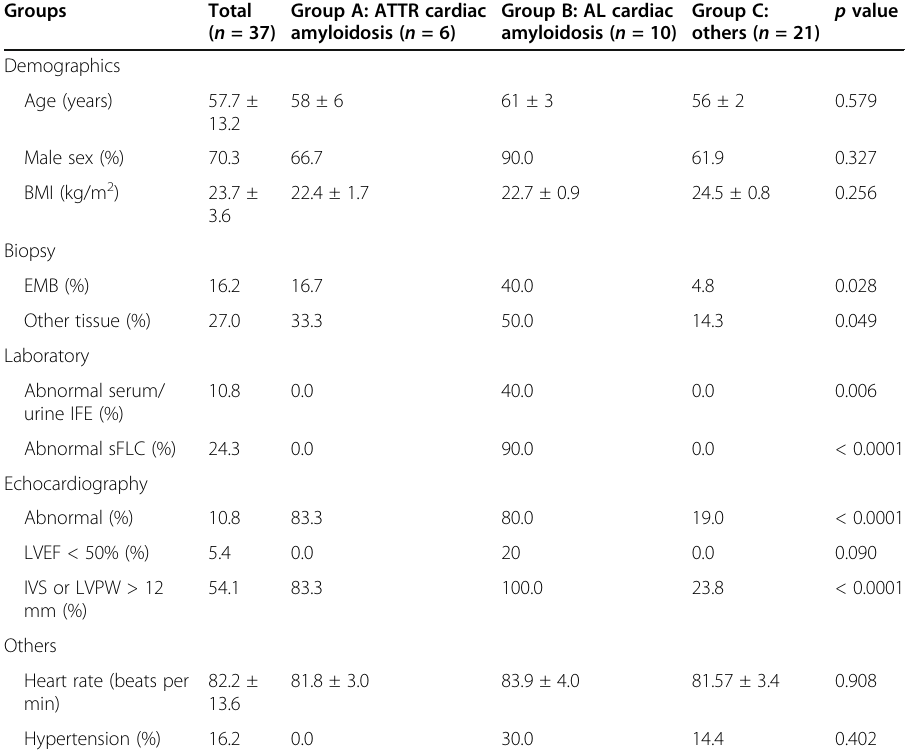
Table 1 Patient characteristics